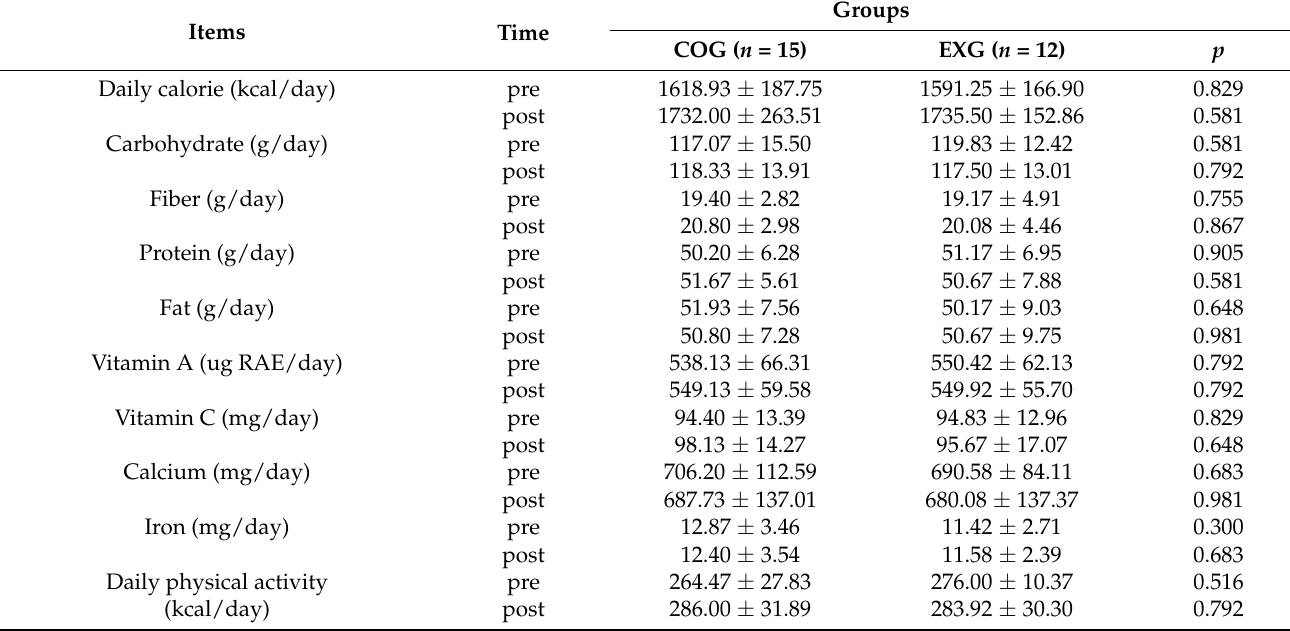
Table 3. Changes and differences in mean daily calorie intake and mean daily calorie